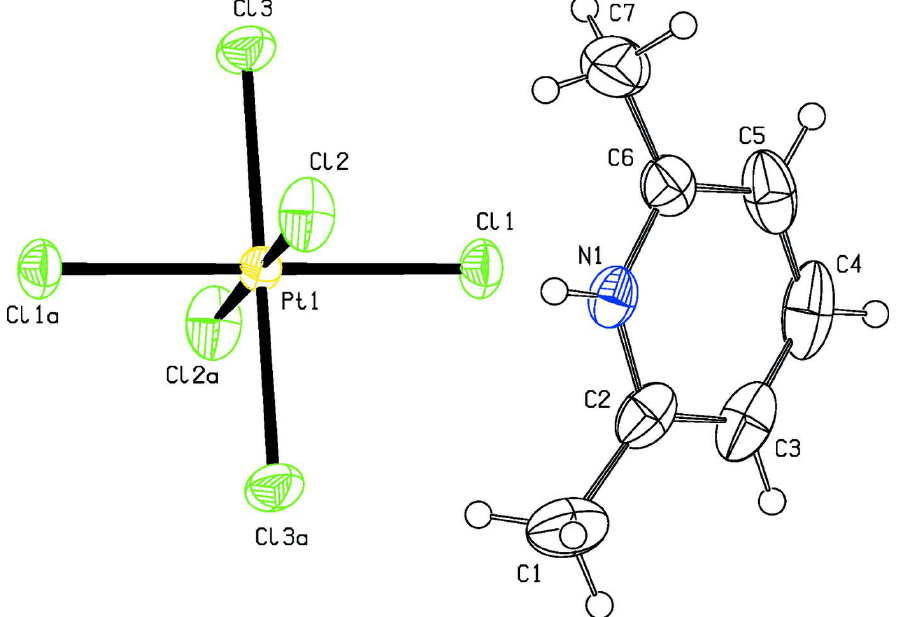
The molecular structure of the title molecule, with the atom-numbering scheme. Displacement ellipsoids are drawn at the 40% probability level [symmetry code: (a) -x, 1 - y,